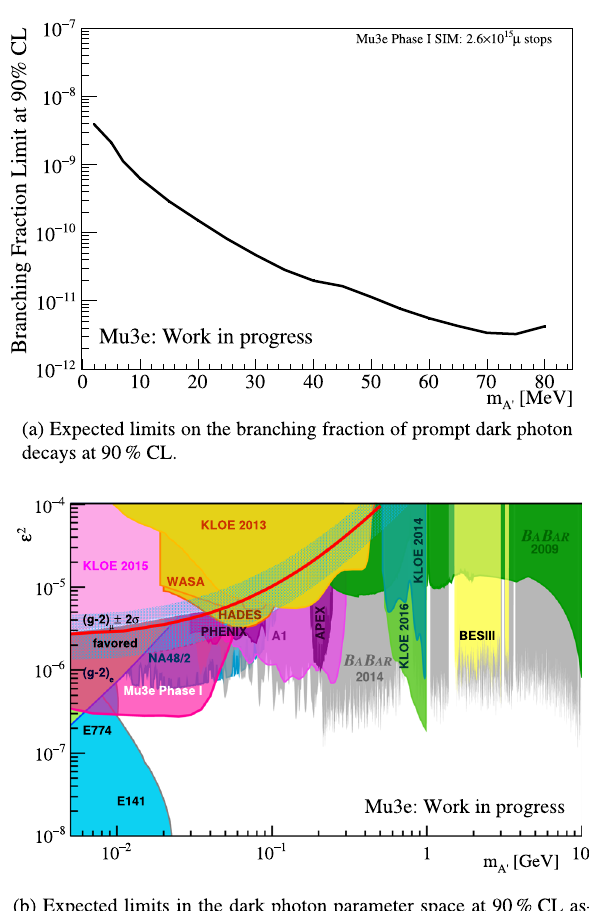
Fig. 43 Expected sensitivity on dark photons emitted in μ → A (cid:4) e νν with prompt decay A (cid:4) → ee in the phase I Mu3e